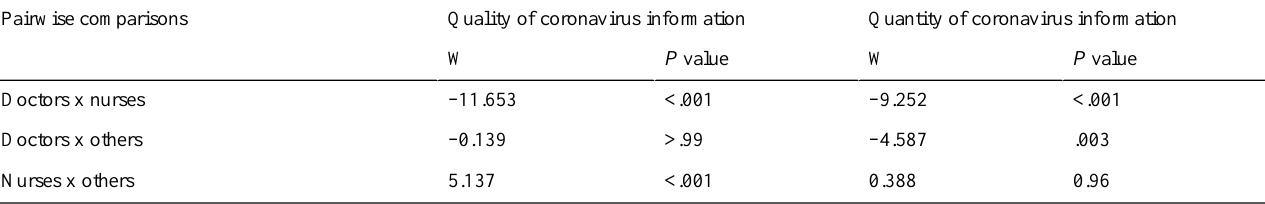
Table 7. Post hoc Dwass-Steel-Critchlow-Fligner pairwise comparison.